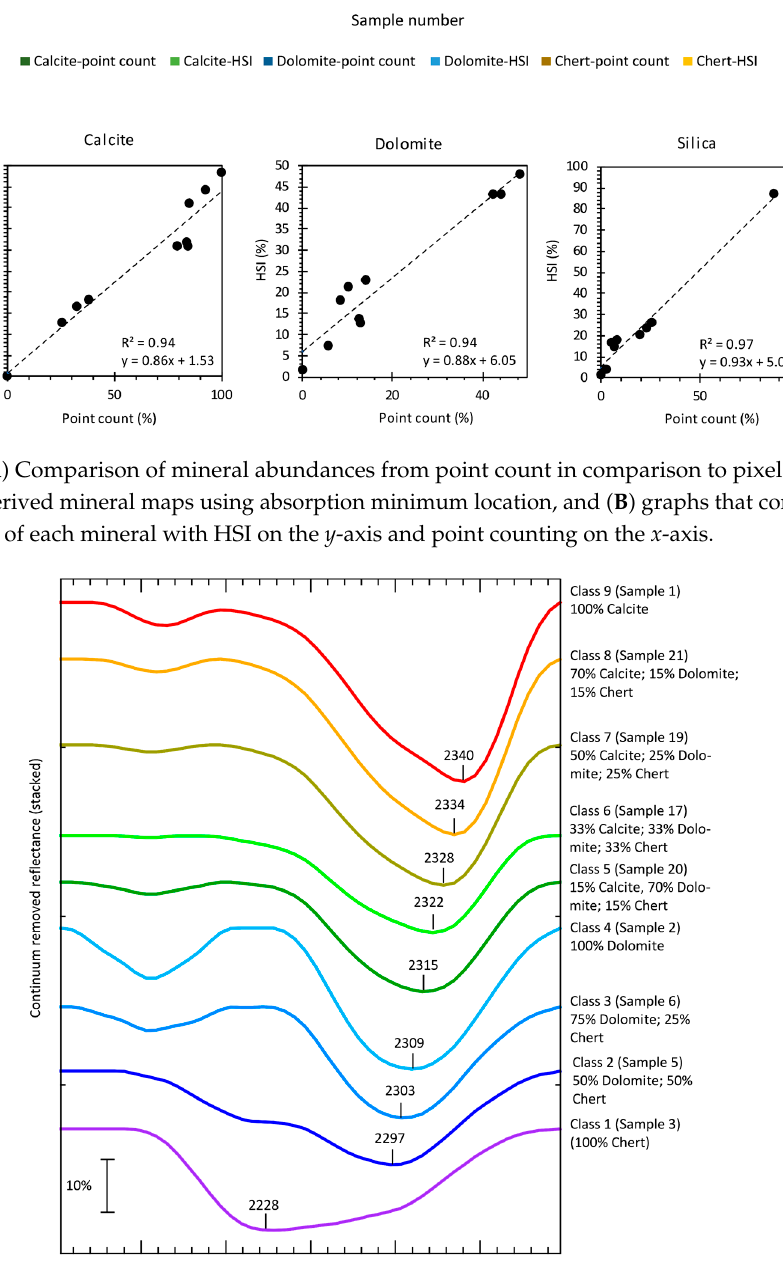
Figure 7. Endmember spectral plots from each class mapped in Figure 8. Sample numbers refer to Table 1.